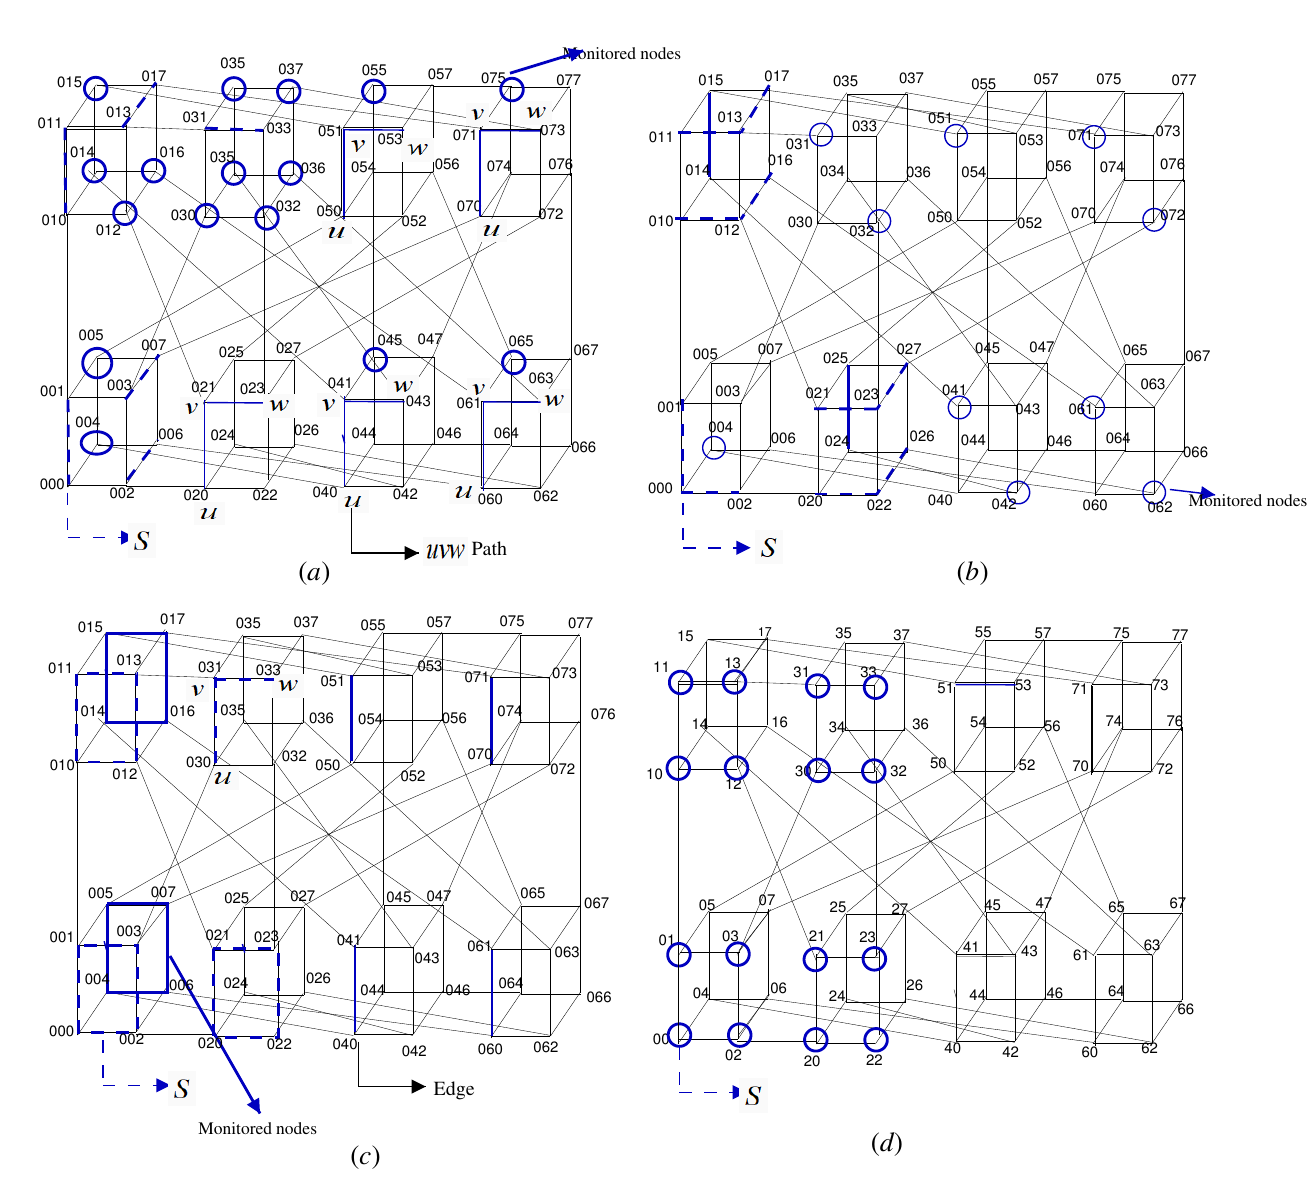
Figure 5. ( a – c ) H 3 of 0 H 2 ( d ) Zero forcing sets of H 2